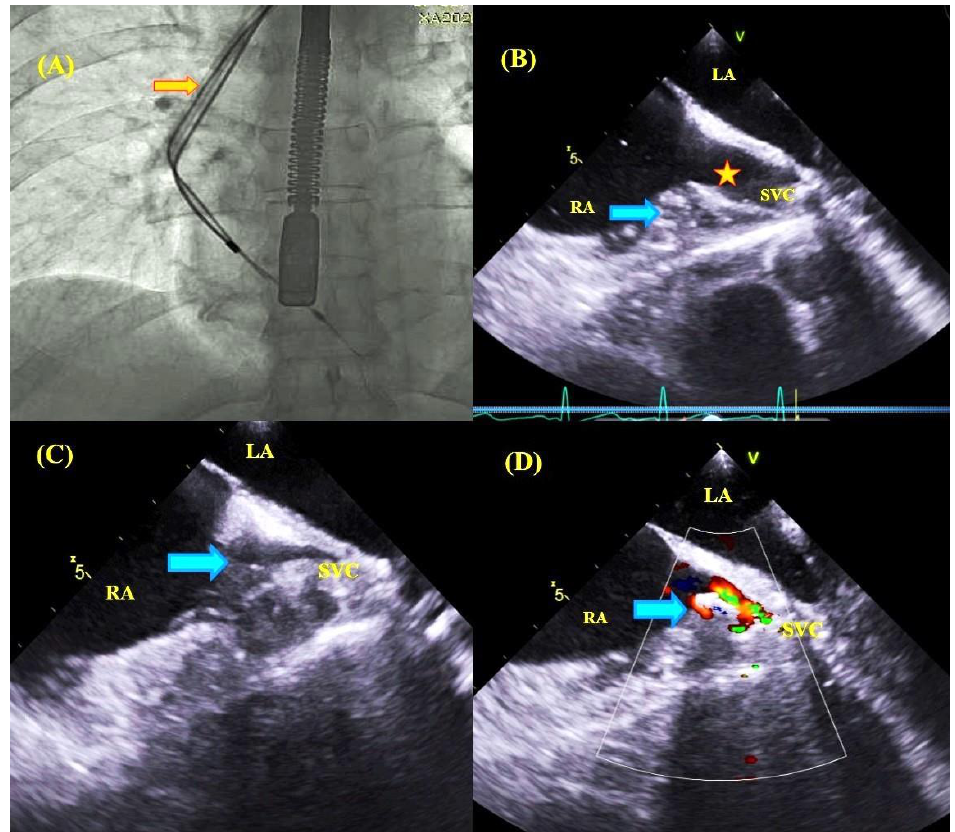
Figure 5. Comparison of fluoroscopic and TEE images during removal of lead-to-lead adhesions. Fluoroscopic image—the moment of ventricular lead extraction with simultaneous pulling on the atrial lead; the Byrd catheter slipped over the ventricular lead (orange arrow) ( A ). TEE images—mid-esophageal view, consecutive phases of pulling on the atrial wall and superior vena cava (blue arrows) until marked obliteration of the vessel during ventricular lead extraction and pulling on atrial lead adhesion ( B – D